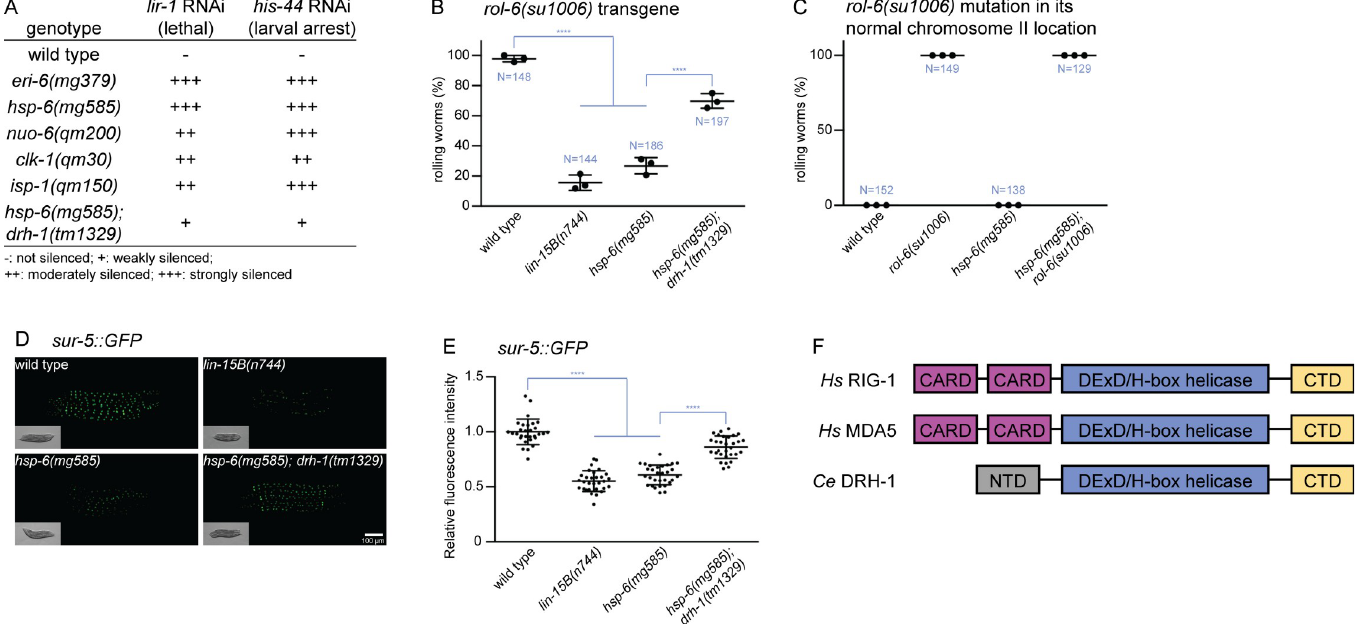
Fig 1. Mitochondrial mutants activate Eri through DRH-1. (A) Eri response to lir-1 RNAi or his-44 RNAi in the mitochondrial mutants hsp-6 , nuo-6 , clk-1 , or isp-1 or the eri-6 Eri mutant causes lethality/arrest but not on wild type. The Eri of the hsp-6 mitochondrial mutant is suppressed by a drh-1 mutation. (B) Transgene silencing test with rol-6(su1006) transgene. This multicopy transgene in wild type causes a rolling behavior due to the expression of an amino acid substitution in the rol-6 collagen gene. The expression of the rol-6 collagen mutation from the multicopy transgene is silenced by Eri in mitochondrial mutants, and this transgene silencing depends on drh-1 gene activity. Results of 3 replicate experiments are shown. N : total number animals tested; ���� denotes p < 0.0001. (C) The mitochondrial mutations do not simply suppress the collagen defect of a rol-6 mutation: If the rol-6(su1006) mutation is chromosomally expressed, not from a transgene that is under RNAi control, the Rol phenotype is not suppressed by hsp-6(mg585) and an hsp-6(mg585) single mutation does not have any Rol phenotype. Results of 3 replicate experiments are shown. N : total number of animals tested. (D and E) Transgene silencing test with sur-5 :: GFP transgene. This transgene is ubiquitously expressed in all somatic cells. The expression of the sur-5 :: GFP from the transgene is silenced by Eri in mitochondrial mutants, and this transgene silencing depends on drh-1 gene activity. Animals were imaged in (D) and the fluorescence was quantified in (E). ���� denotes p < 0.0001. (F) Diagrams of human RIG-I, MDA5, and C . elegans DRH-1. The helicase domain and CTD are conserved. The underlying numerical data can be found in S1 data. CARD, caspase recruitment domain; Ce , Caenorhabditis elegans ; CTD, C-terminal domain; Eri, enhanced RNAi; Hs , Homo sapiens; NTD, N-terminal domain; RNAi, RNA interference.